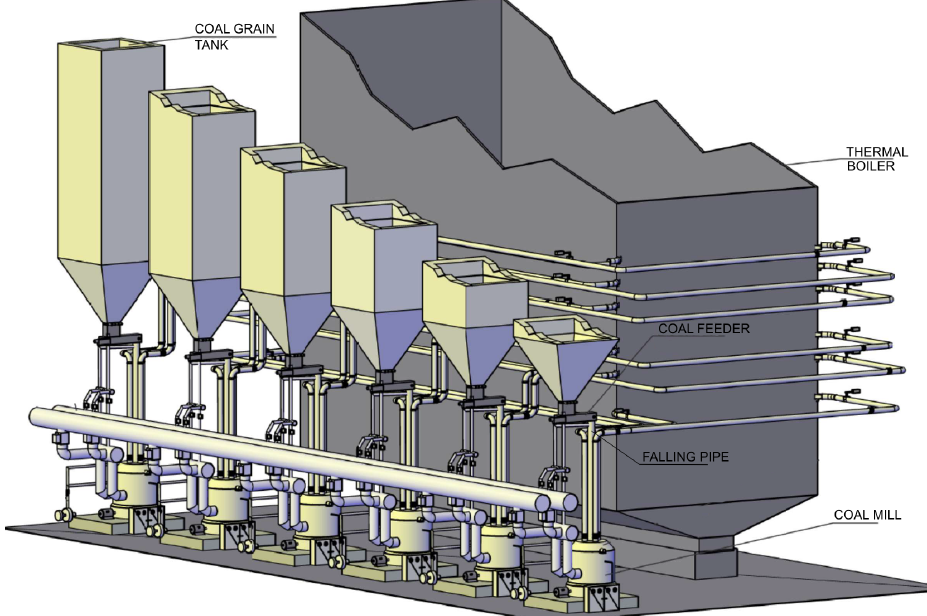
Figure 1. Schematic overview of the coal feeding system of a power plant with six